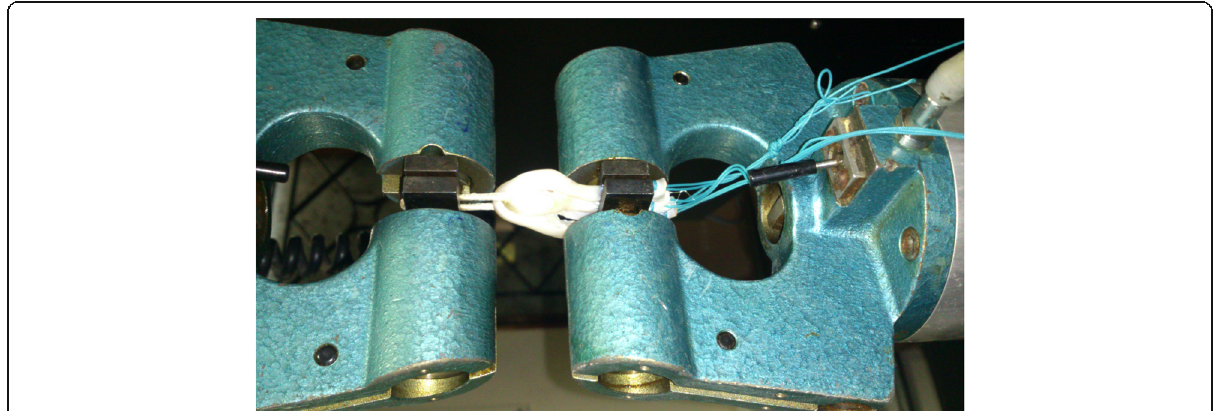
Fig. 5 Quadrupled graft construct in test